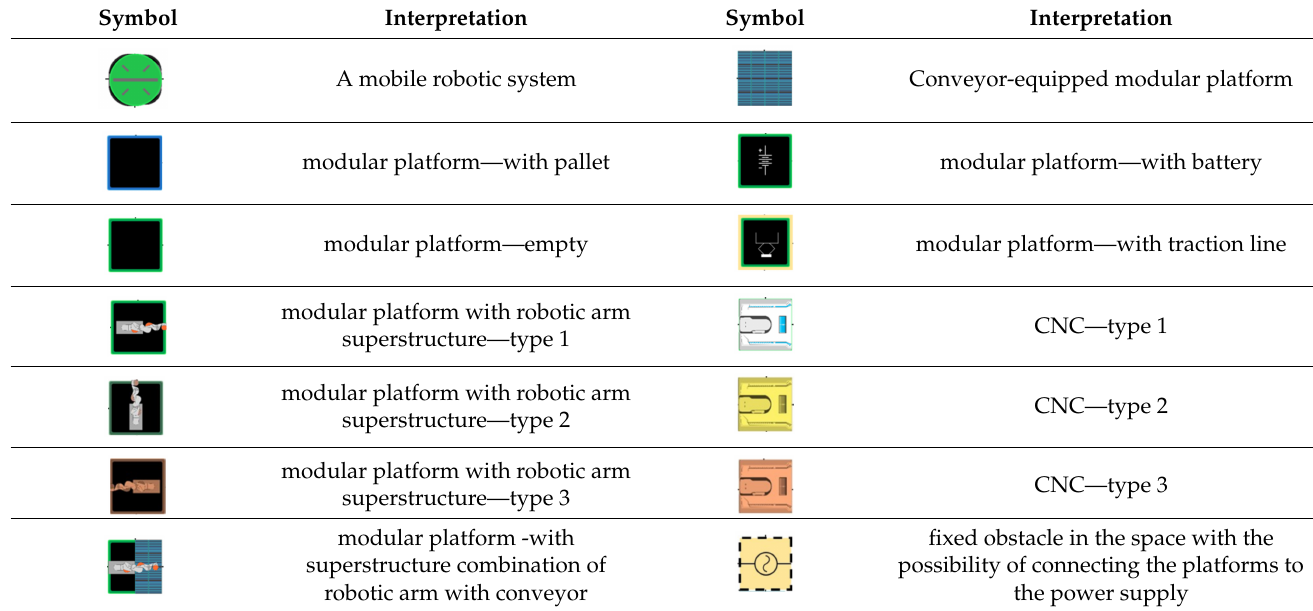
Table 2. Symbols and their interpretations.